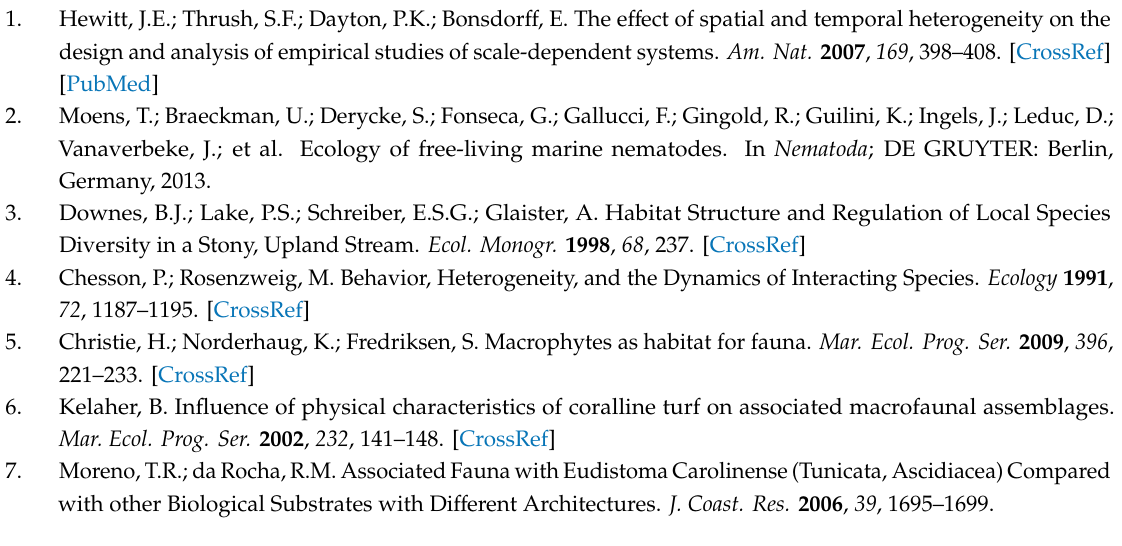
Table S1: Mean density (inds.ml − 1 ) and standard deviation (in parenthesis) of meiofauna higher taxa in the di ff erent biological substrates sampled in a rocky-shore from Araç á Bay, Southeast Brazil; Table S2: Mean density (inds. mL − 1 ) and standard deviation (in parenthesis) of nematode morphospecies in the di ff erent biological substrates sampled in a rocky shore from Araç á Bay, Southeast Brazil; Table S3: Mean density (inds. mL − 1 ) and standard deviation (in parenthesis) of macrofauna higher taxa in the di ff erent biological substrates sampled in a rocky shore from Araç á Bay, Southeast Brazil; Table S4: Mean density (inds. mL − 1 ) and standard deviation (in parenthesis) of meiofauna higher taxa associated with Bostrychia sp. sampled from the rocky shore habitats and mangrove roots at Araç á Bay, Southeast Brazil; Table S5: Mean density (inds. mL − 1 ) and standard deviation (in parenthesis) of nematode species associated with Bostrychia sp. sampled from the rocky shore habitats and mangrove roots at Araç á Bay, Southeast Brazil; Table S6: Mean density (inds. mL − 1 ) and standard deviation (in parenthesis) of macrofauna taxa associated with Bostrychia sp. sampled from the rocky shore habitats and mangrove roots at Araç á Bay, Southeast Brazil; Table S7: SIMPER analysis showing nematode species ranked according to average Sorensen dissimilarity from presence / absence data between the biological substrates ‘Caulerpa’ and ‘Turf’; Table (x + 1) data between the rocky shore habitats and mangrove roots; Table S9: SIMPER analysis showing